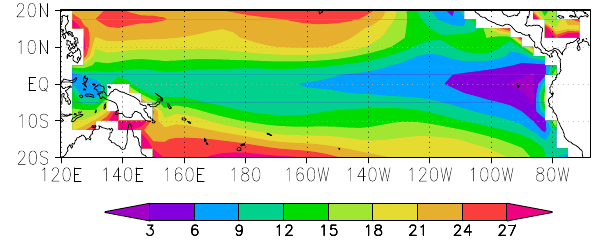
Fig. 4. Atmospheric noise standard deviation in [10 − 3 Nm − 2 ] of the STAM member.